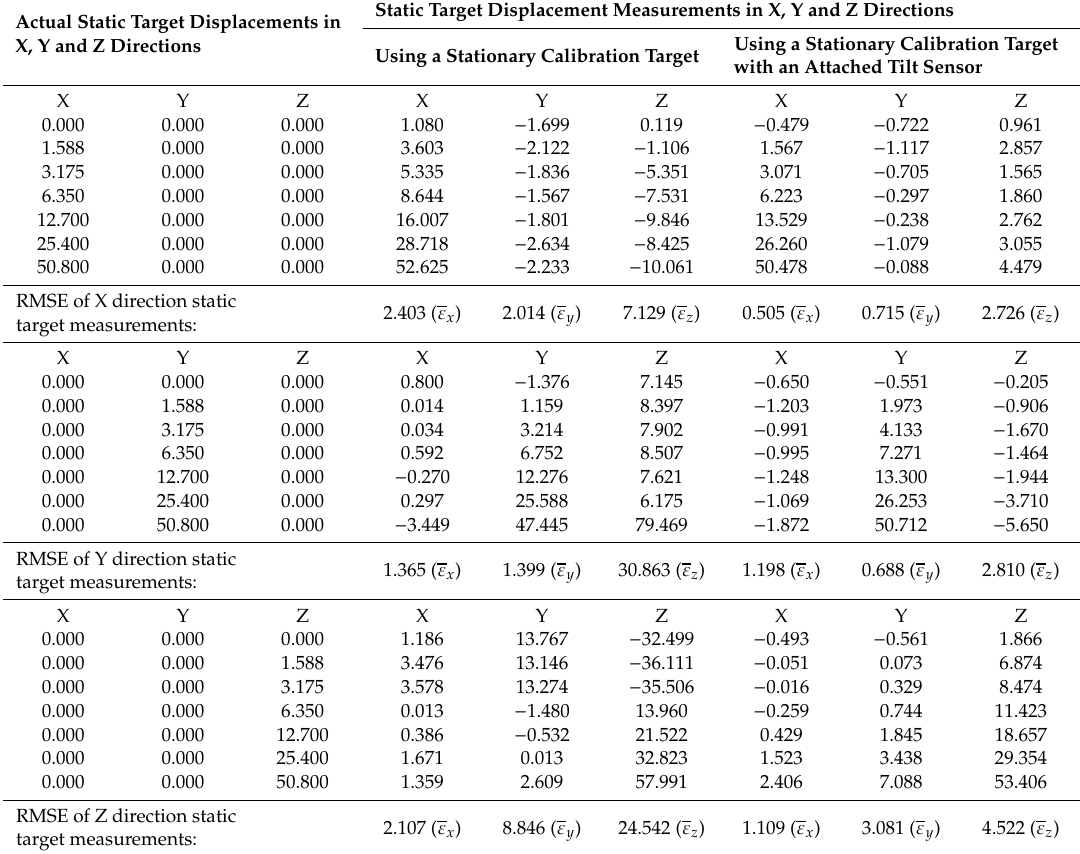
Table 4. Evaluations on the synthetic static target displacements using a moving camera